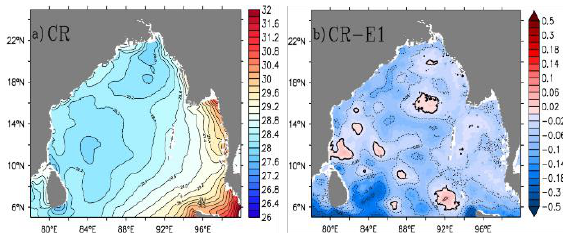
Figure 3. Time-mean sea surface temperature (SST, 0C) of (a) CR and the time-mean differences between (b) CR and E1 for the year 2015